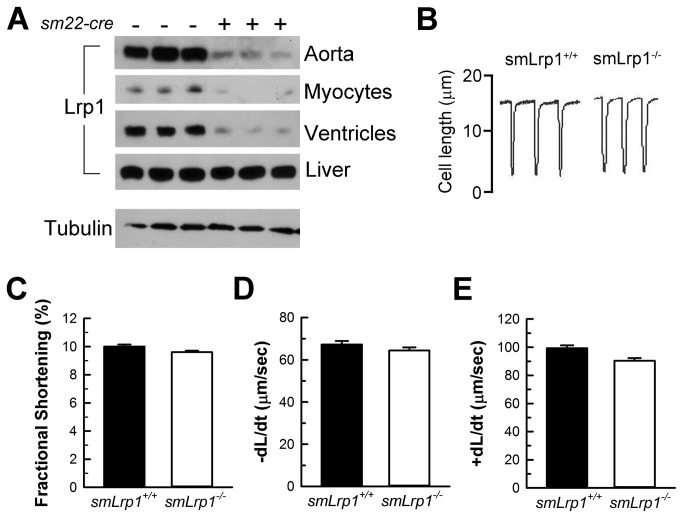
Lrp1 disruption in cardiovascular tissues and isolated cardiac myocyte function.
A, Immunoblots of Lrp1 in tissue and cell extracts from heart, aorta, liver and cardiomyocytes demonstrated disruption of Lrp1 protein in cardiovascular tissues of sm22-cre Lrp1flox/flox mice. Cardiomyoctye mechanics were demonstrated in (B) representative cell shortening tracings of smLrp1+/+ and smLrp1-/- cardiomycytes, as well as (C) fractional shortening, (D) rates of relaxation, -dL/dt, and (E) rates of contraction, +dL/dt. n = 3 mice per group for Lrp1 immunoblots and n = 27 cells from 3 smLrp1-/- hearts; n = 20 cells from 2 smLrp1+/+ hearts. Data are mean ± SEM.